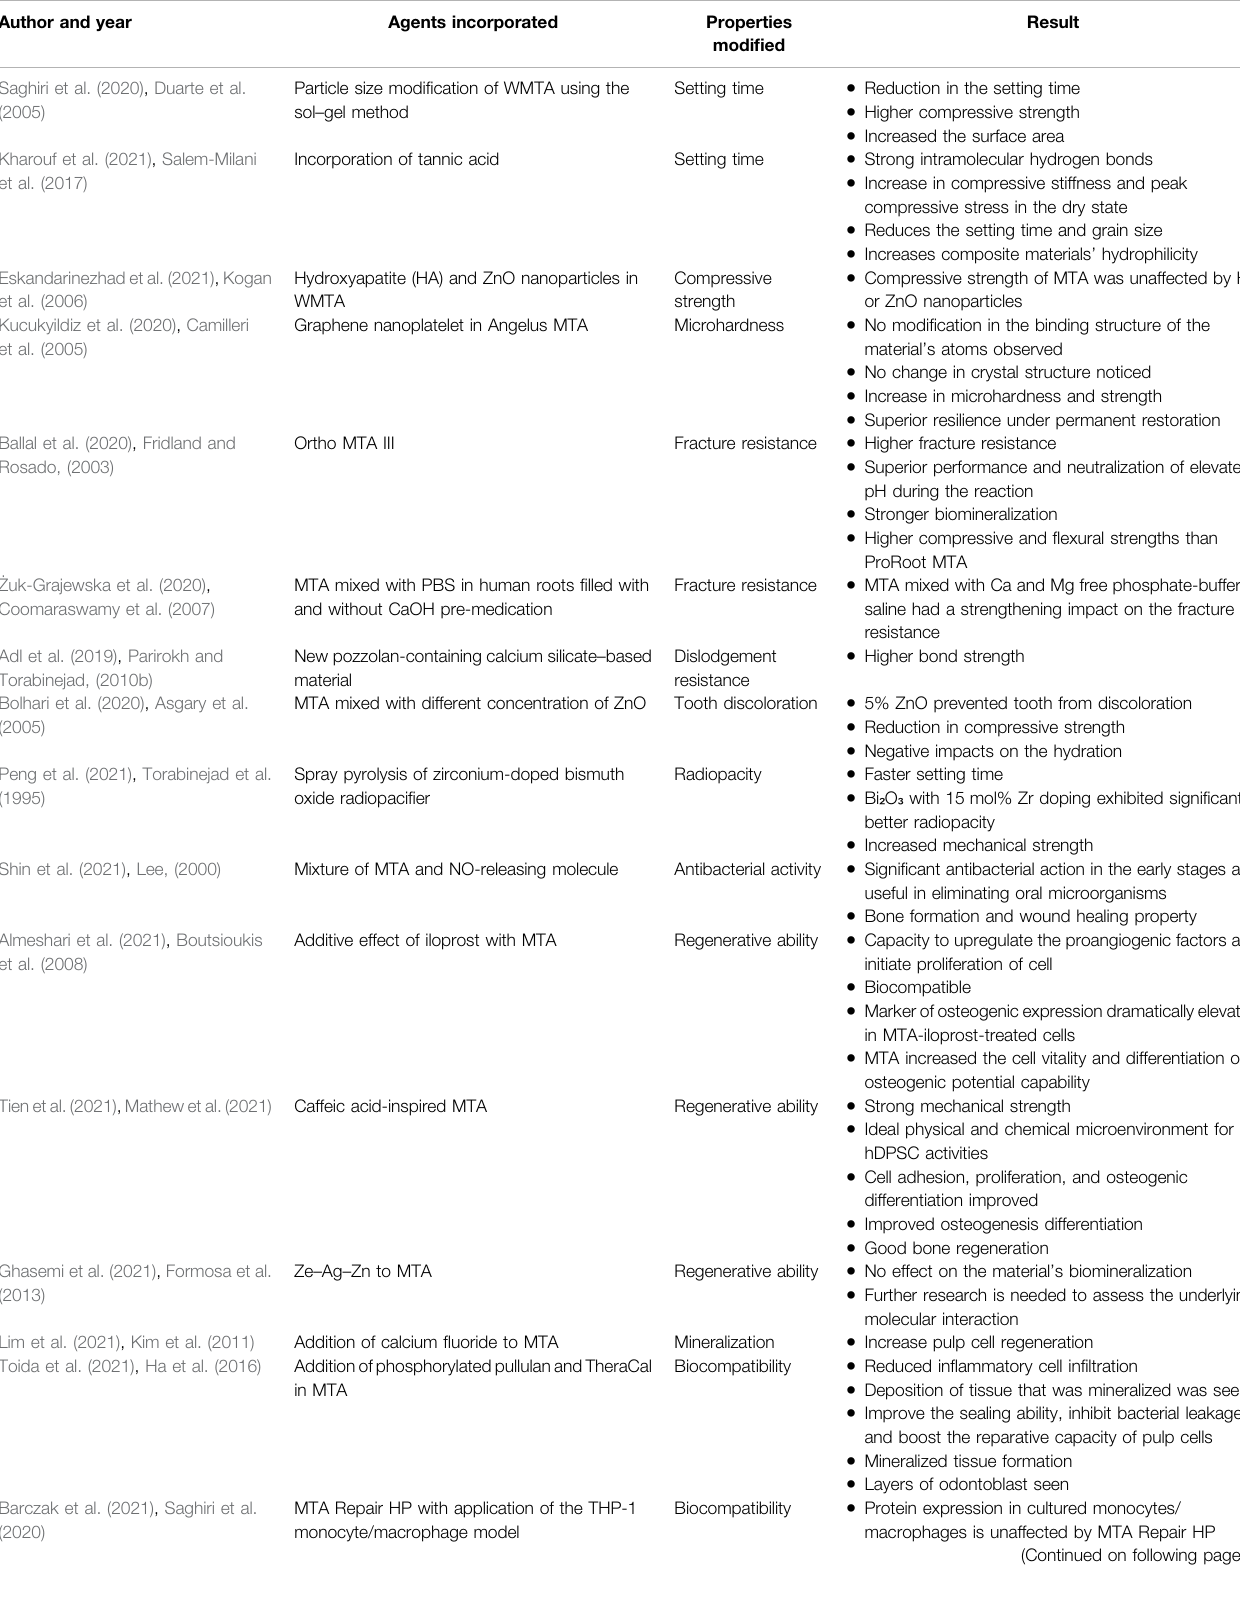
TABLE 2 | Summary of studies relevant to modi fi cations of